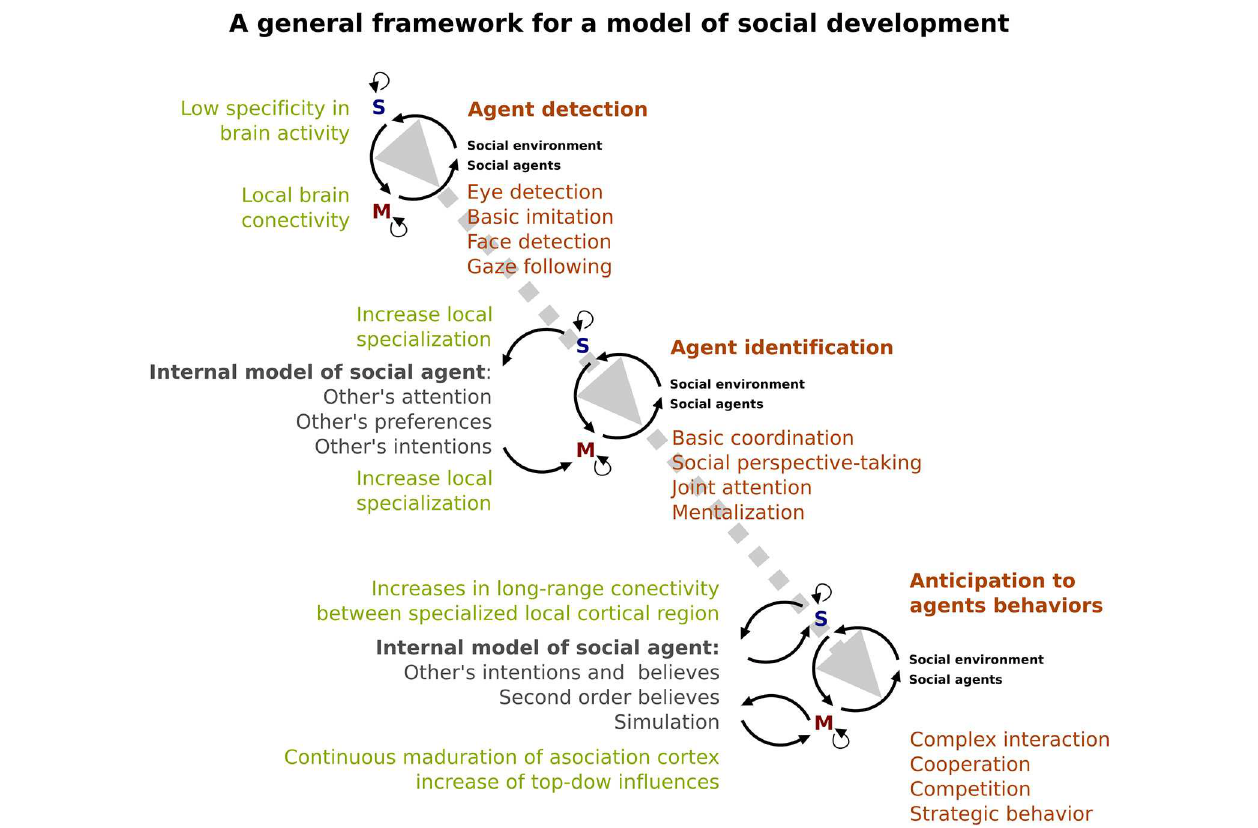
FIGURE 3 | A specialized brain. A model of the developing social brain. Dotted gray line represents the interaction between neural (light green) and behavioral (orange) development. Note that the gray arrow shows an increase in the complexity of that interaction across ages. Dark green shows the emergence and complexity of the internal cognitive model of the social agent. Black lines represent the relationship between sensory (blue S) and motor systems (red M).